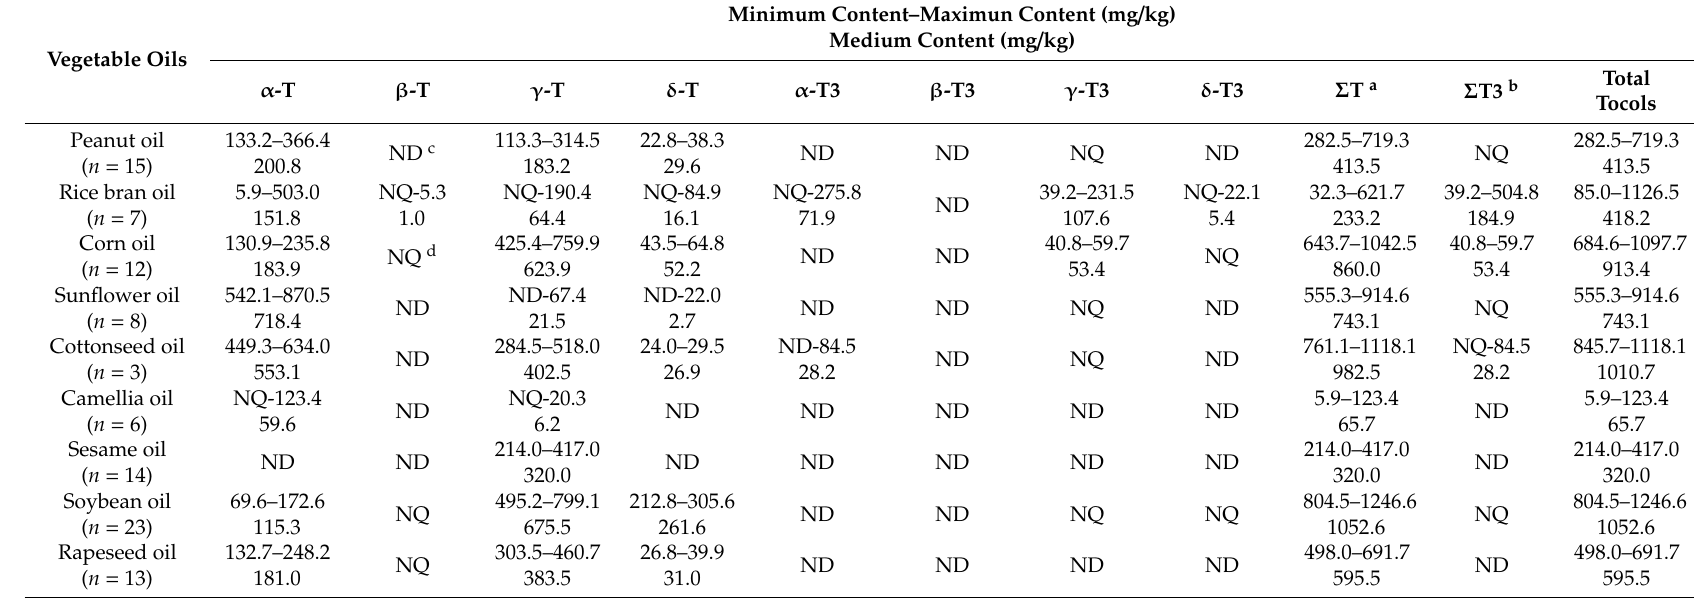
Table 1. The compositions and contents (mg / kg) of tocols in nine types of selected first-grade traditional edible